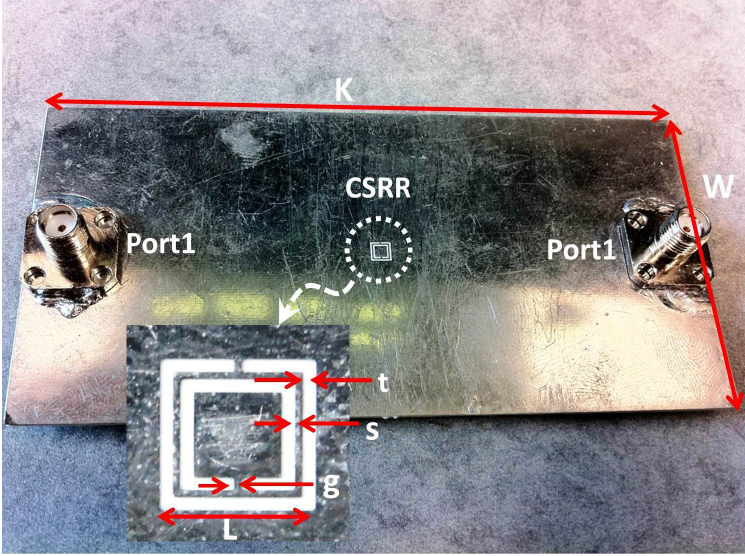
The CSRR printed on the ground plane of a microstrip line with its